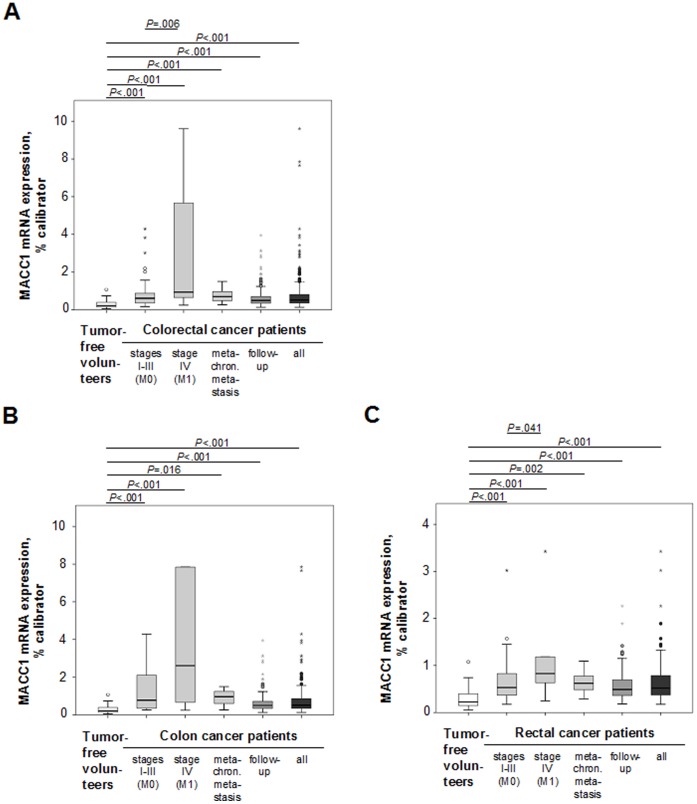
Circulating MACC1 transcripts in colorectal, colon, and rectal cancer patient plasma.A, B, C. All colorectal (A, n = 312), colon (B, n = 151), and rectal (C, n = 161) cancer patient sub-cohorts showed significantly higher circulating MACC1 transcript levels than tumor-free volunteers (n = 54). Higher MACC1 levels were also found for colorectal (P = .006; A) and rectal (P = .041; C) cancer patients with synchronous metastases (n = 20 and n = 10, respectively) compared to patients without distant metastases (n = 51 and n = 39, respectively). Box plot analysis, based on quantitative real-time RT-PCR.